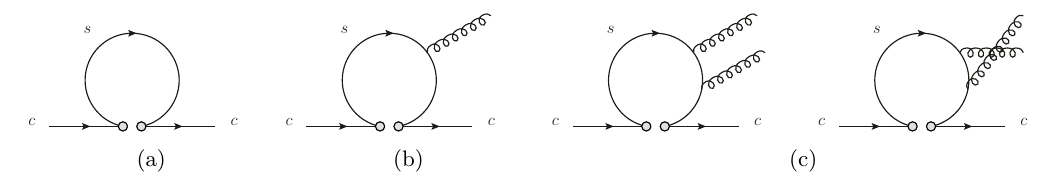
Figure 5 . Diagrams determining the mixing of four-quark operators into two-quark